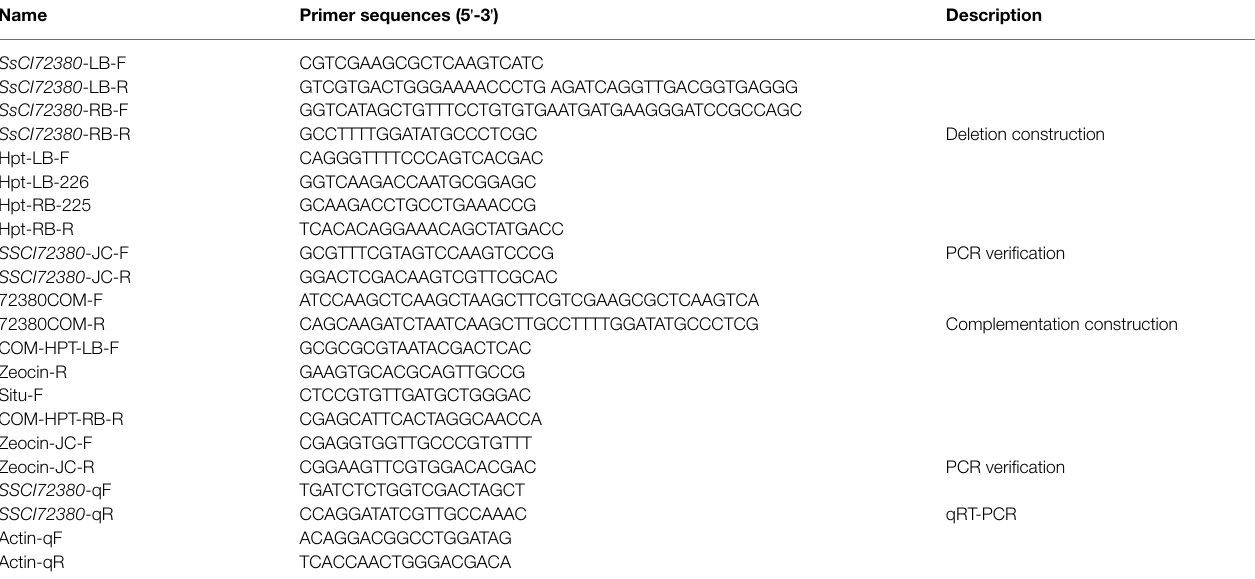
TABLE 1 | Primers used in this